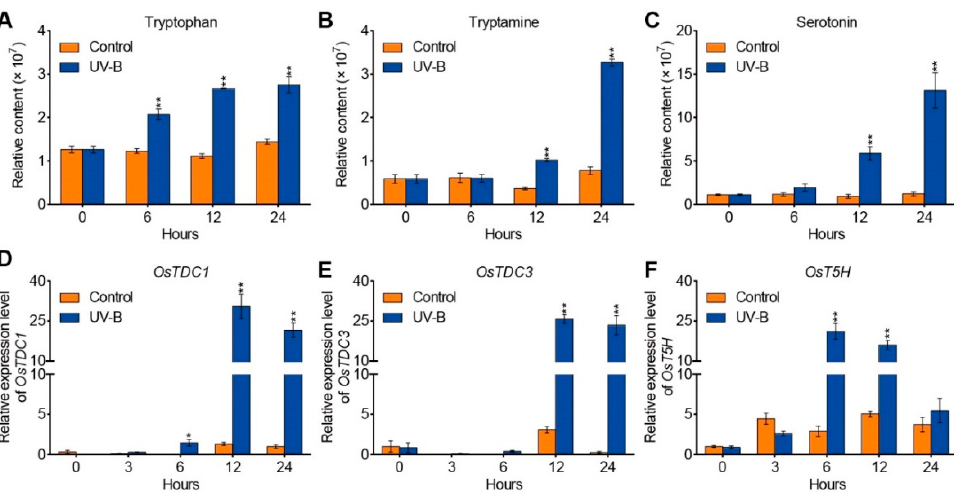
Figure 1. Serotonin biosynthesis in Zhonghua11 (ZH11) increased under UV-B radiation. ( A – C ) Accumulation of tryptophan ( A ), tryptamine ( B ), and serotonin ( C ) in the leaves of ZH11 under UV-B radiation. ( D – F ) Expression analysis of serotonin biosynthesis genes OsTDC1 ( D ), OsTDC3 ( E ), and OsT5H ( F ) under control and UV-B radiation conditions. The relative expression levels were normalized to those of ubiquitin . Two-week-old seedlings were subjected to UV-B for 0, 3, 6, 12, and 24 h. The data are means ± SD of three biological replicates. Asterisks indicate a significant difference between the control and UV-B treatments at individual time points (* p < 0.05 and ** p < 0.01, Student’s t -test).